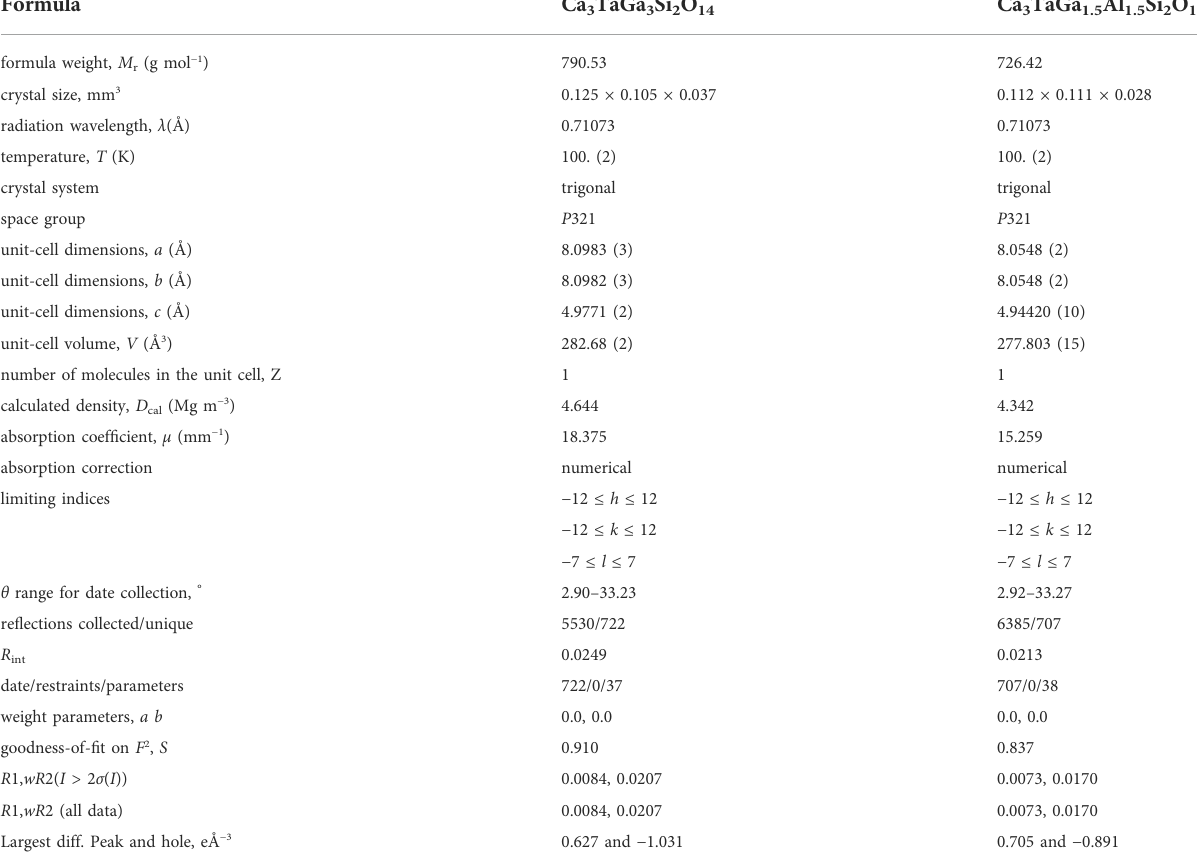
TABLE 1 Crystal data and re fi nement results for Ca 3 TaGa 3 Si 2 O 14 (CTGS) and Ca 3 TaGa 1.5 Al 1.5 Si 2 O 14